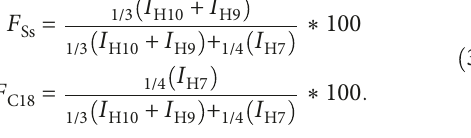
Figure 11: 1 H NMR characterization of PBISu